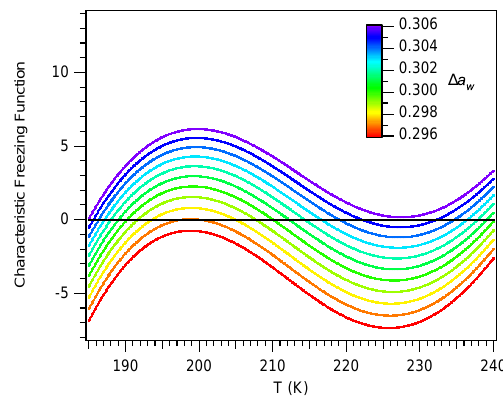
Fig.7. Characteristicfreezingfunctionfor D p =10 (cid:22) mand (cid:1) t =10 s. Figure 7. Characteristic freezing function for D p = 10µm and 1t =